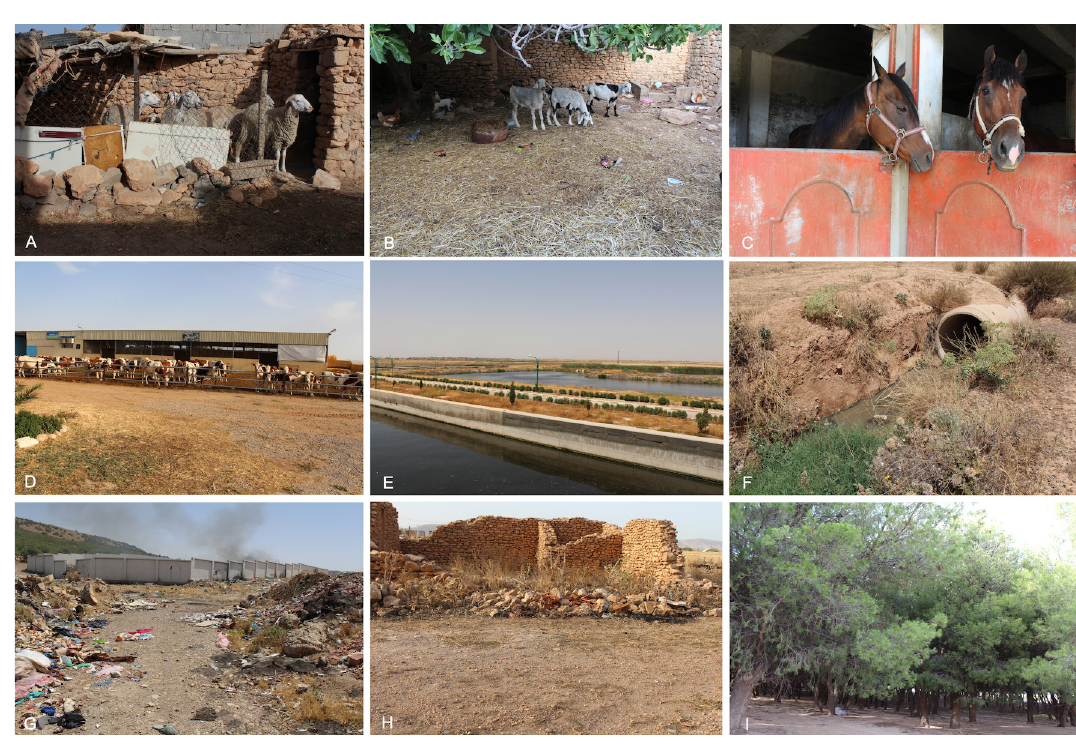
Fig 2. Phlebotomine sand fly collection sites (A–I) in Setif province, North-Eastern Algeria. (A) sheep shelter, (B) goat shelter, (C) horse shelter, (D) goat shelter, (E) water treatment station, (F) discharge of waste water, (G) discharge of domestic waste, (H) old building, and (I) coniferous